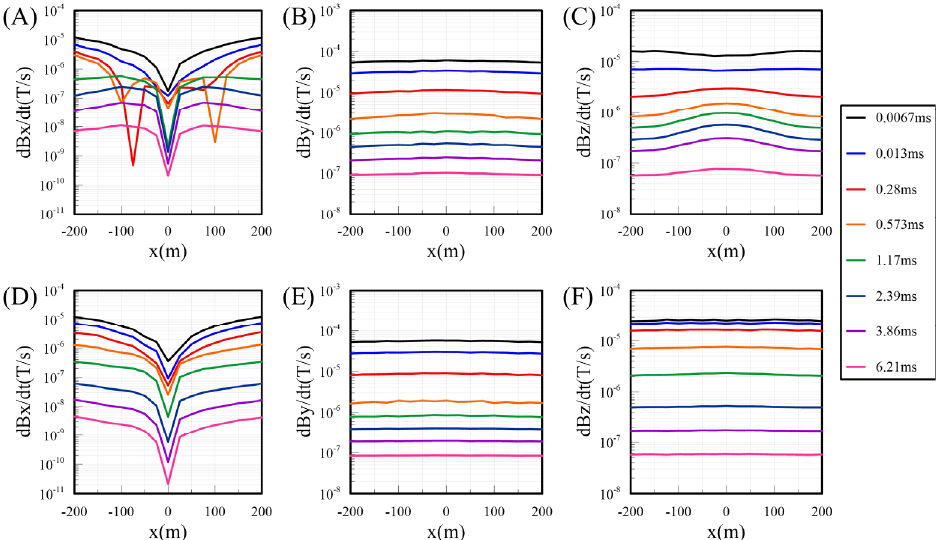
Figure 3. EM responses for the plate models in Figure 2 at y= 0 m. ( A ) – ( C ) are the dBx/dt, dBy/dt and dBz/dt for the Horizontal plate model; ( D ) – ( F ) are the dBx/dt, dBy/dt and dBz/dt for the Vertical plate model.